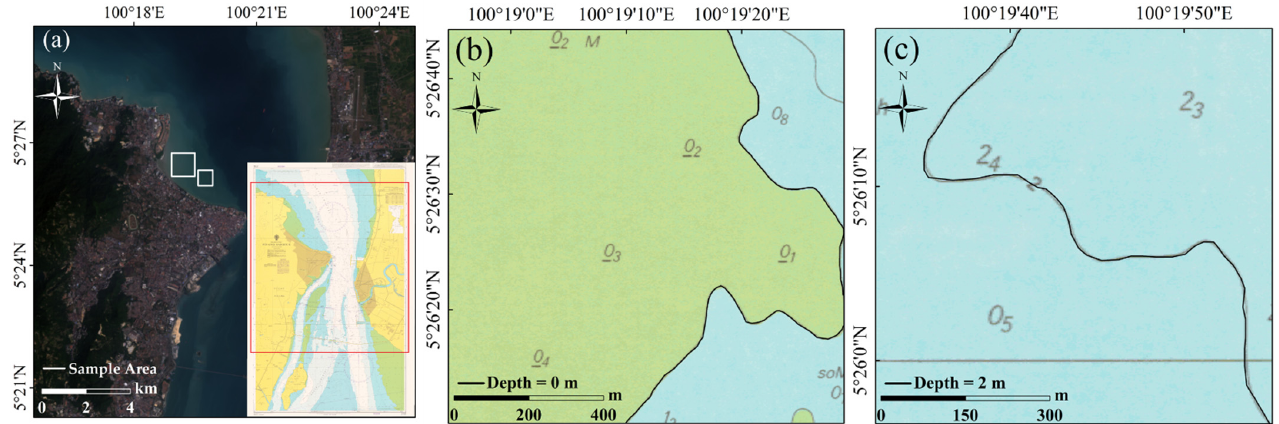
Figure 8. Sample bathymetric map of Penang. ( a ) shows the distribution of two sample areas in Penang; ( b , c ) show the sea charts of the sample areas. The large sample area corresponds to ( b ) and contains a 0-m depth contour; the small sample area corresponds to ( c ) and contains a 2-m depth contour.